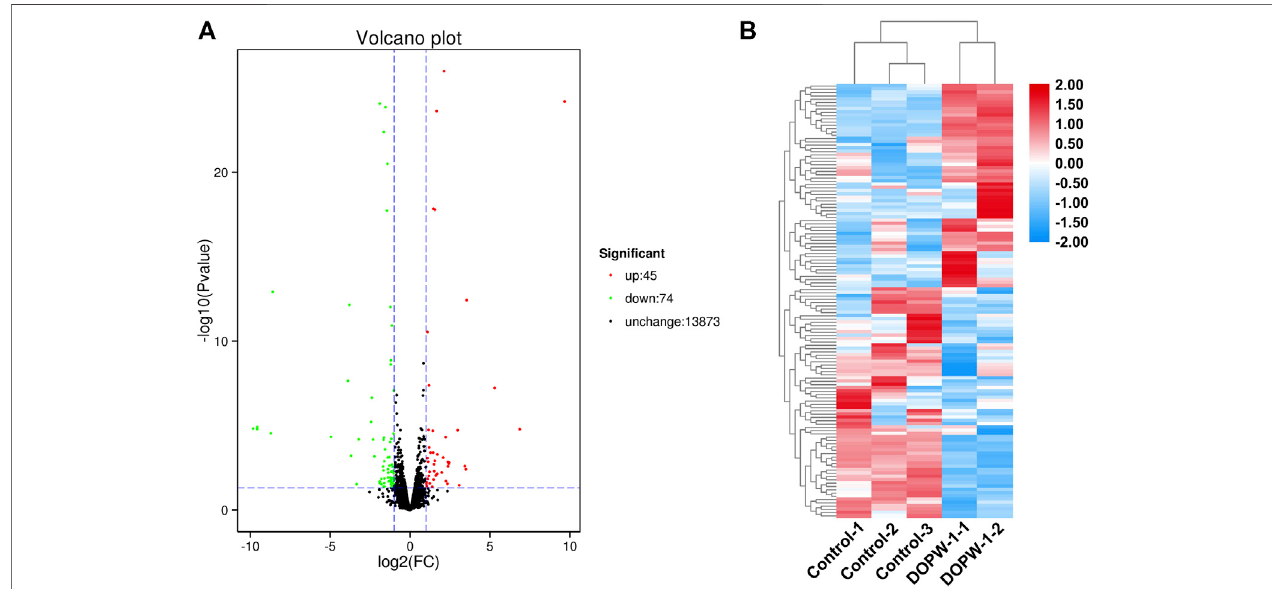
FIGURE 3 | (A) Volcano map of DEGs between the DOPW-1 and control groups. Black, red, and green dots represent genes with no signi fi cant change in expression, signi fi cantly upregulated expression, and signi fi cantly downregulated expression in DEGs, respectively. (B) Hierarchical clustering of DEGs for the DOPW-1 group vs . the control group. Different colors represent different gene expressions in the DOPW-1 and control groups.